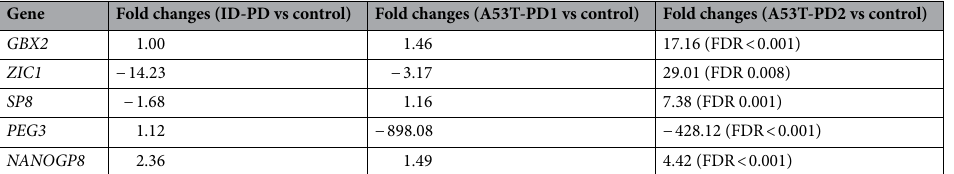
Table 2. Five selected genes based on fold change and